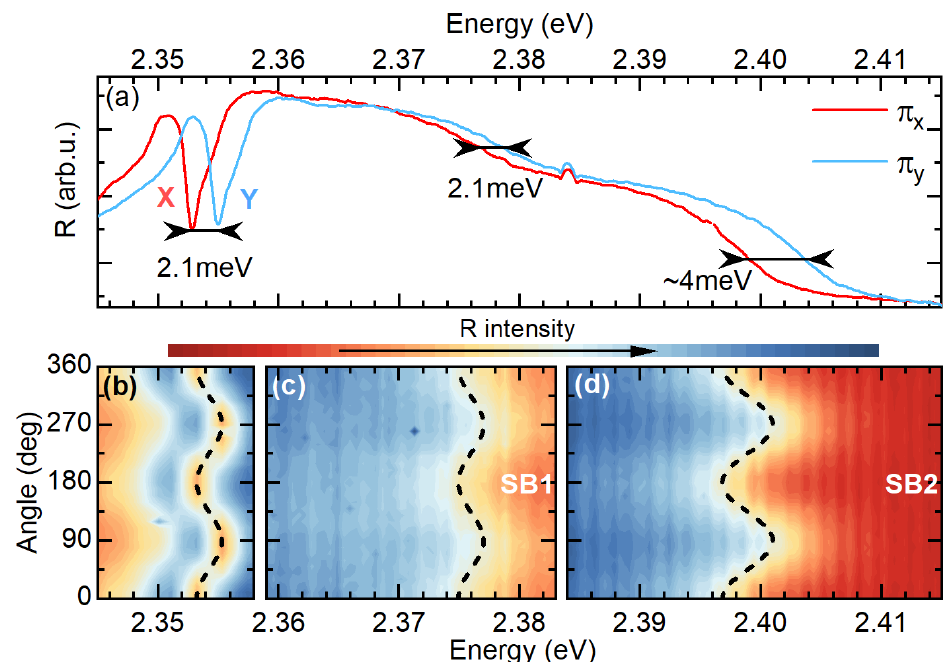
Figure 3. ( a ) Polarization resolved spectra of reflectance for π X and π Y polarization. ( b – d ) Depen- dence of the reflectance spectrum as a function of the polarization angle. The intensity in each panel is adjusted to emphasize the splitting in a given spectral range. ∆ XY sin 2 ( α ) is plotted in dashed black lines, which shows the oscillatory behaviour of the transition energy as a function of detection